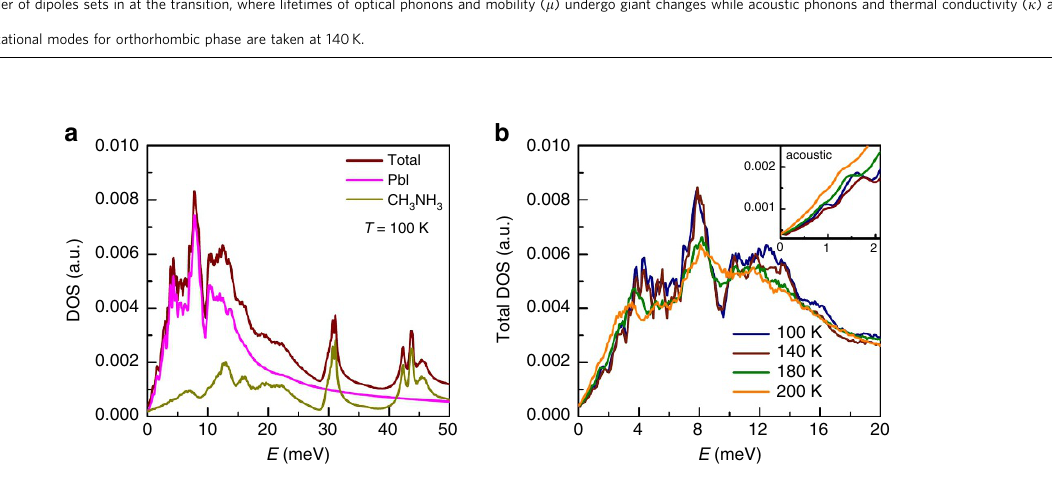
Figure 5 | Phonon DOS calculated in simulations. ( a ) The total and partial (contributed by the inorganic and molecular species) DOS at 100K. ( b ) The total DOS at 100, 140, 180 and 200K. The inset shows the acoustic phonons located in the low-energy region, which are less broadened than the optical ones during the orthorhombic-to-tetragonal phase